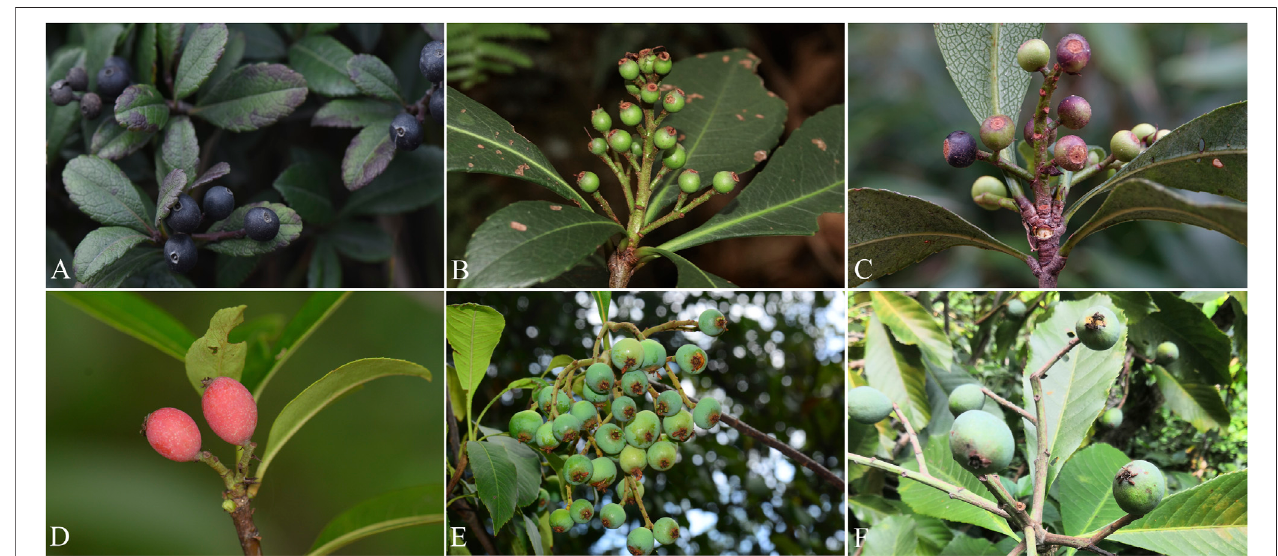
FIGURE 6 | The caducous sepals — Rhaphiolepis indica (A) , Rhaphiolepis major (B) , Rhaphiolepis umbellate (C) and the persistent sepals — Eriobotrya henryi (D) , Eriobotrya bengalensis var. angustifolia (E), Eriobotrya serrata (F) .